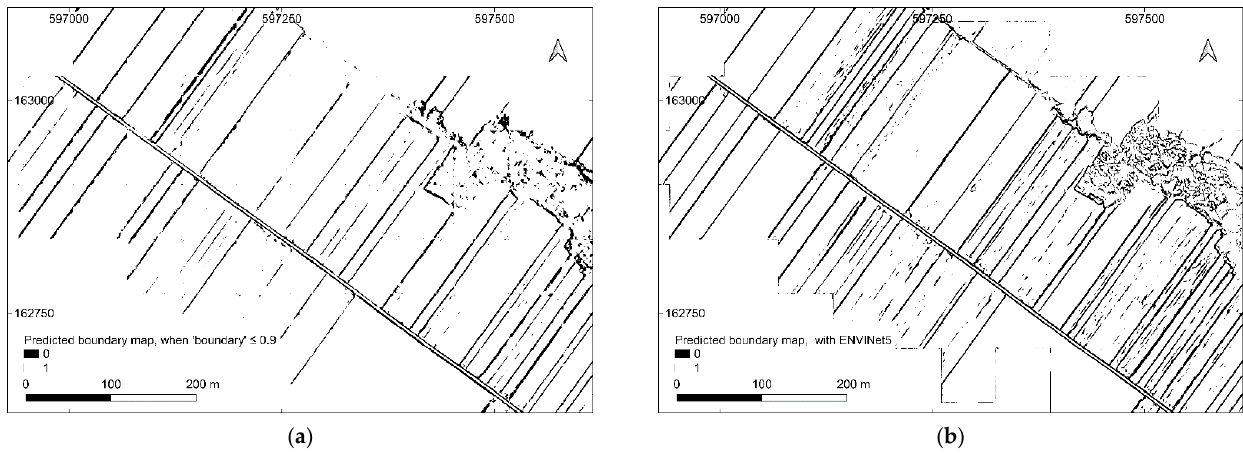
Figure 9. Comparison of predicted land boundary map: ( a ) predicted boundary map retrieved with U-Net, threshold ‘boundary’ ≤ 0.9; ( b ) predicted boundary map retrieved with ENVINet5.